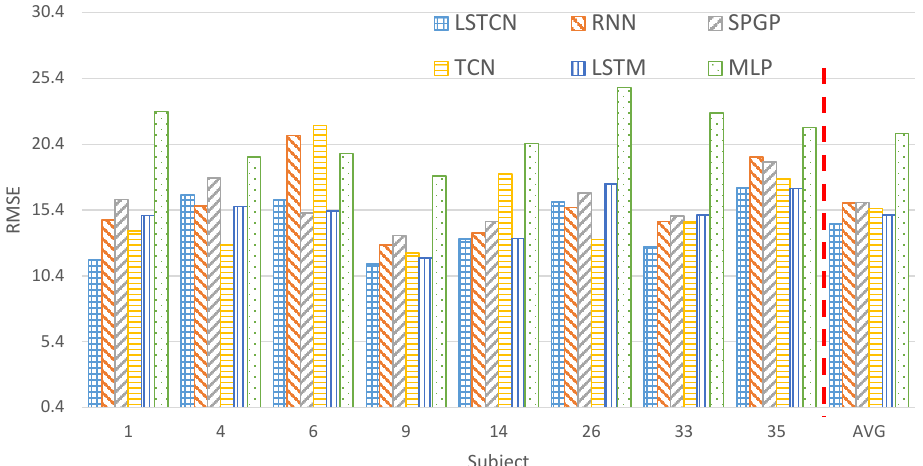
Figure 8. Summary of the RMSE of 8 subjects. RMSE denotes the root mean square error between predicted joint angles and real joint angles. The lower, the better.